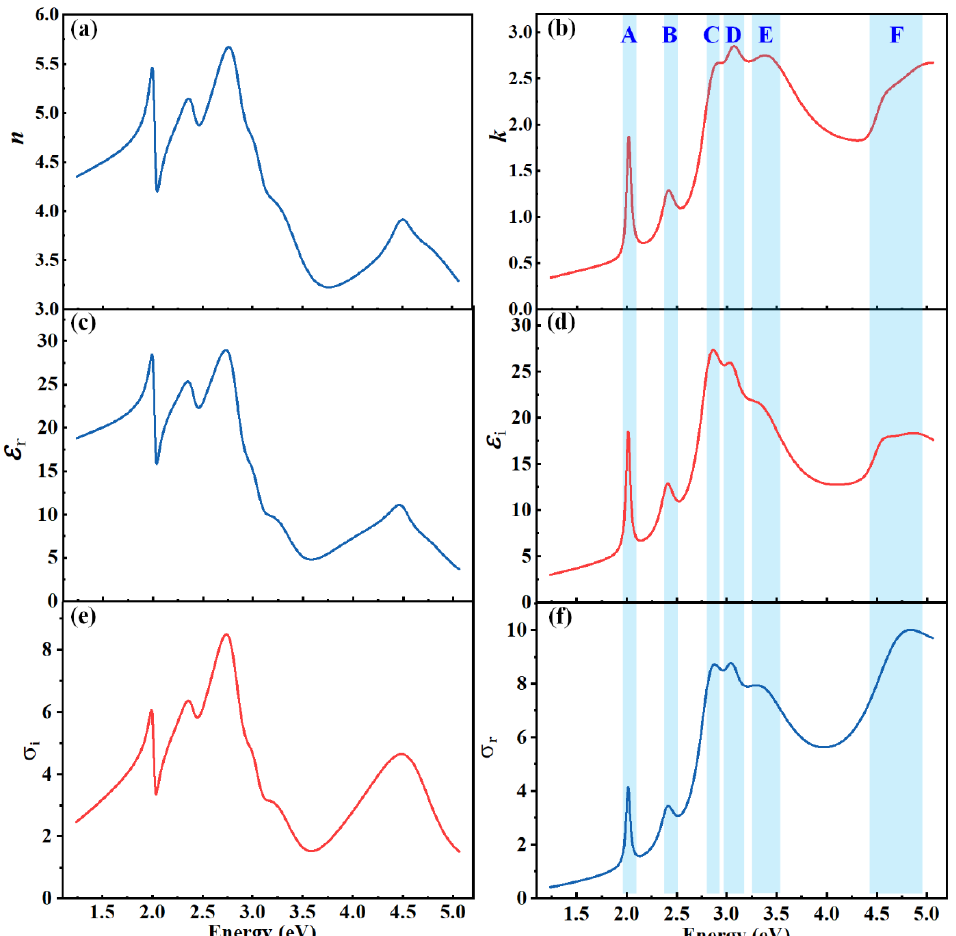
Figure 4. Optical functions of the monolayer WS 2 determined by the SE: ( a , b ) refractive index n and extinction coefficient k ; ( c , d ) real part ε r and imaginary part ε i of the dielectric function; ( e , f ) imaginary part σ i and real part σ r of the optical conductivity. Uppercase letters A–F represent the